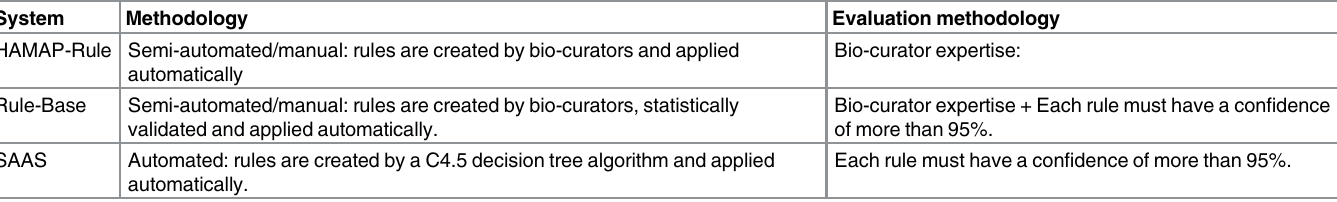
Table 10. Overview of HAMAP-Rule, Rule-Base, and SAAS.